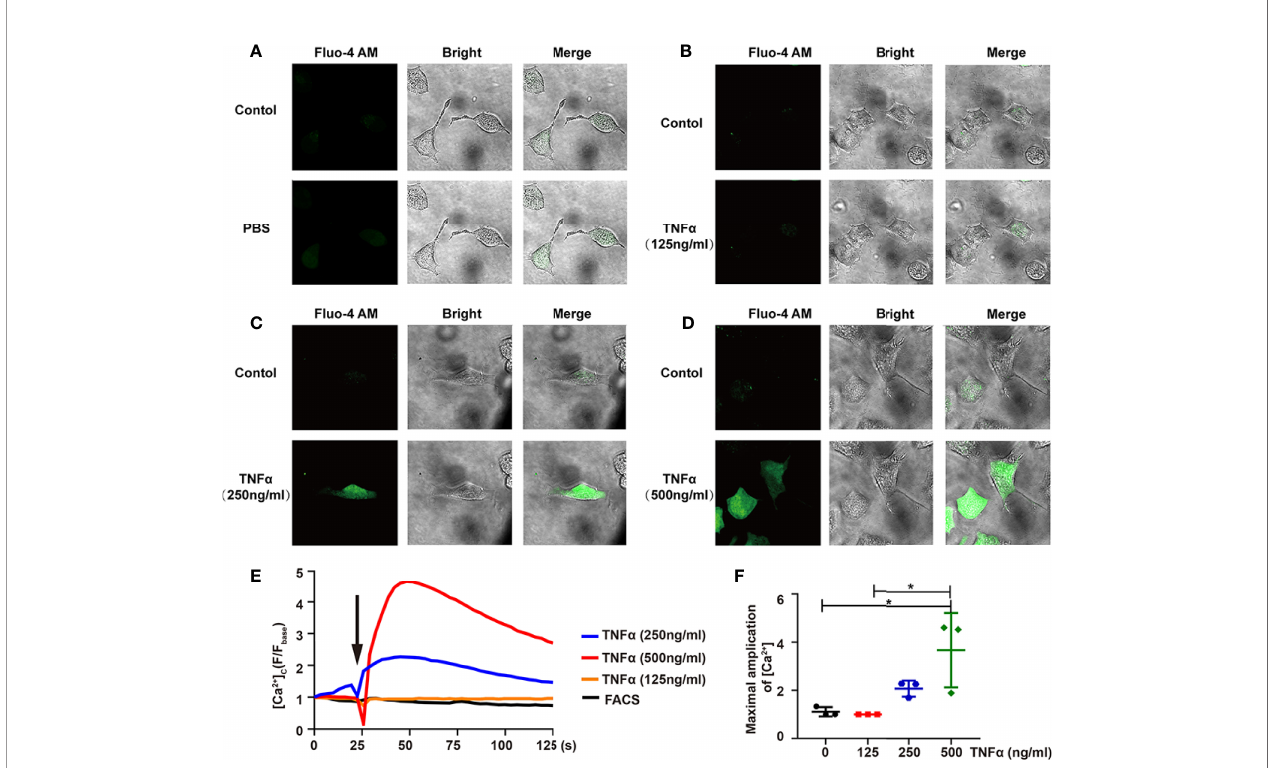
FIGURE 6 | TNF- a induces Ca 2+ in fl ux in differentiated ND7/23 cells. (A-D) The relative intensity of Fluo-4 AM fl uorescence - and bright- fi eld images were shown in PBS (A) , 125ng/mL TNF- a (B) , 250ng/mL TNF- a (C) , 500ng/mL TNF- a (D) . The Control group indicated the background before adding the stimulator. Images were taken by confocal microscope. (E) Confocal microscope analysis of [Ca 2+ ] in ND7/23 cells with PBS and TNF- a stimulation. Arrow indicated cells stimulated by PBS or TNF- a . (F) Quantitative analysis of the maximal increased level of cytosolic Ca 2+ after stimulations. *P <